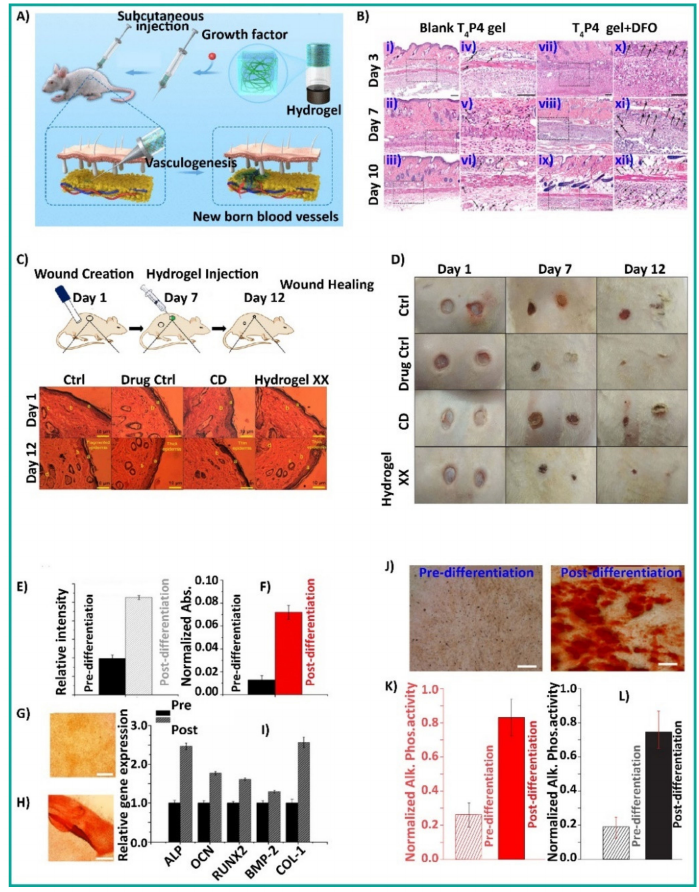
Figure 22. ( A ) Schematic illustration of in vivo angiogenesis employing a tetrapeptide supramolecular hydrogel; ( B ) (i), (ii), and (iii) H&E stained images of the DFO excluded implanted T 4 P4 gel at 3, 7, and 10 days, respectively; (iv), (v), and (vi) high amplification images of the boxed areas shown in (i), (ii), and (iii), respectively; (vii), (viii), and (ix) H&E stained images of the DFO included implanted T 4 P gel at 3, 7, and 10 days, respectively; (x), (xi), and (xii) high amplification images of the boxed areas shown in (vii), (viii), and (ix), respectively; reproduced with permission from Ref. [123]. Copyright (2018) American Chemical Society. ( C ) H&E stained epithelial tissue histology images; a, epidermis layer; b, dermis layer; c, sweat gland; and d, sebaceous gland; ( D ) Digital images of D 2 P12 abd β -CD co-assembled hydrogel that assisted in vivo wound healing at day 1, 7, and 12, respectively; reproduced with permission from Ref. [151]. Copyright (2020) American Chemical Society. Osteogenenic response on the Alginate/D 2 P12 composite hydrogel. ( E ) Alkaline phosphatase (ALP) activity. ( F ) Calcification quantification of Alizarin red stained MC3T3-E1 preosteoblast cells 3 days after seeding on alginate/D 2 P14 composite hydrogel and following 14 days of osteogenic differentiation; optical images of Alizarin red stained MC3T3-E1 preosteoblast cells; ( G ) after 3 days; ( H ) after 14 days. ( I ) Quantification of relative mRNA expression of osteogenic genes (ALP, OCN, RUNX2, BMP-2, and Col-I) of MC3T3-E1 preosteoblast cells 3 days after seeding on alginate/D 2 P14 composite hydrogel and following 14 days of osteogenic differentiation; reproduced with permission from Ref. [175]. Copyright (2019) MDPI AG; MDPI. Osteogenic response of MC3 T3-E1 cells on the HA/D 2 P27 composite hydrogel. ( J ) Optical images of Alizarin red stained MC3 T3-E1 preosteoblast cells prior to (pre-differentiation) and after (post-differentiation) 14 days of osteogenic differentiation on HA/D 2 P27 composite hydrogel; reproduced with permission from Ref. [167]. Copyright (2021) MDPI AG; MDPI. ( K ) Calcification. ( L ) Alkaline phosphatase (ALP) activity quantification of Alizarin red stained of MC3 T3-E1 preosteoblasts before and after 14 days of osteogenic differentiation on HA/D 2 P27 composite hydrogel; reproduced with permission from Ref. [167]. Copyright (2021) MDPI AG;